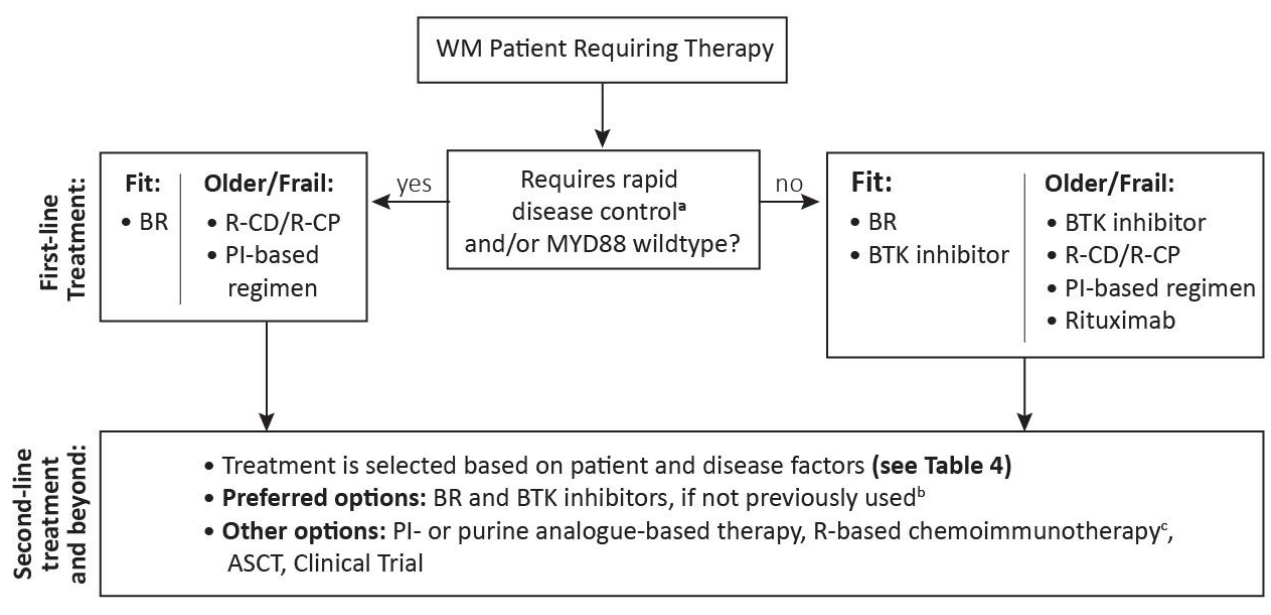
Figure 1. Treatment algorithm for symptomatic Waldenström macroglobulinemia requiring treatment initiation (cf. Table 4). a Plasmapheresis is indicated in patients with symptomatic hyperviscocity. Prophylactic plasmapheresis may be considered in patients who have asymptomatic elevated IgM, cryoglobulinemia, cold agglutinin disease, or IgM mediated neuropathy. b BR may be repeated if patients remained progression-free for 2–3 years after response to first-line BR c Exclude rituximab if progressed <12 months on prior rituximab-based therapy. ASCT, autologous stem cell transplant; BR, bendamustine-rituximab; BTK, Bruton’s Tyrosine Kinase; PI, proteasome inhibitor; R, rituximab; R-CD, rituximab-cyclophosphamide-dexamethasone; R-CP, rituximab-cyclophosphamide-prednisone; WM, Waldenström macroglobulinemia.